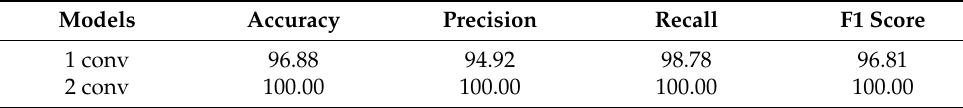
Table 14. Performance of damage diagnosis